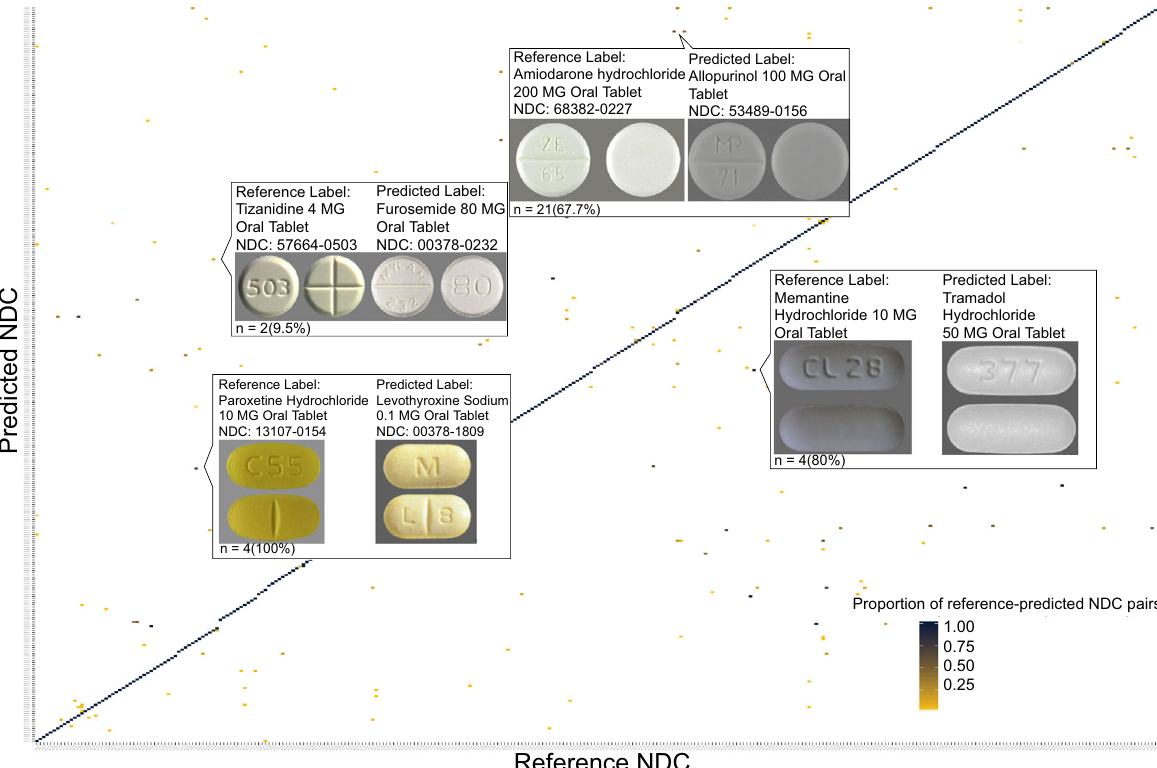
Fig. 3 Confusion matrix normalized by proportion of all predicted and reference National Drug Code images. Proportion equal to the predicted National Drug Code (NDC) count for given reference image divided by the count of all reference images of that NDC). 1 = the same NDC was predicted each time; 0 = no cases of reference image being a particular predicted